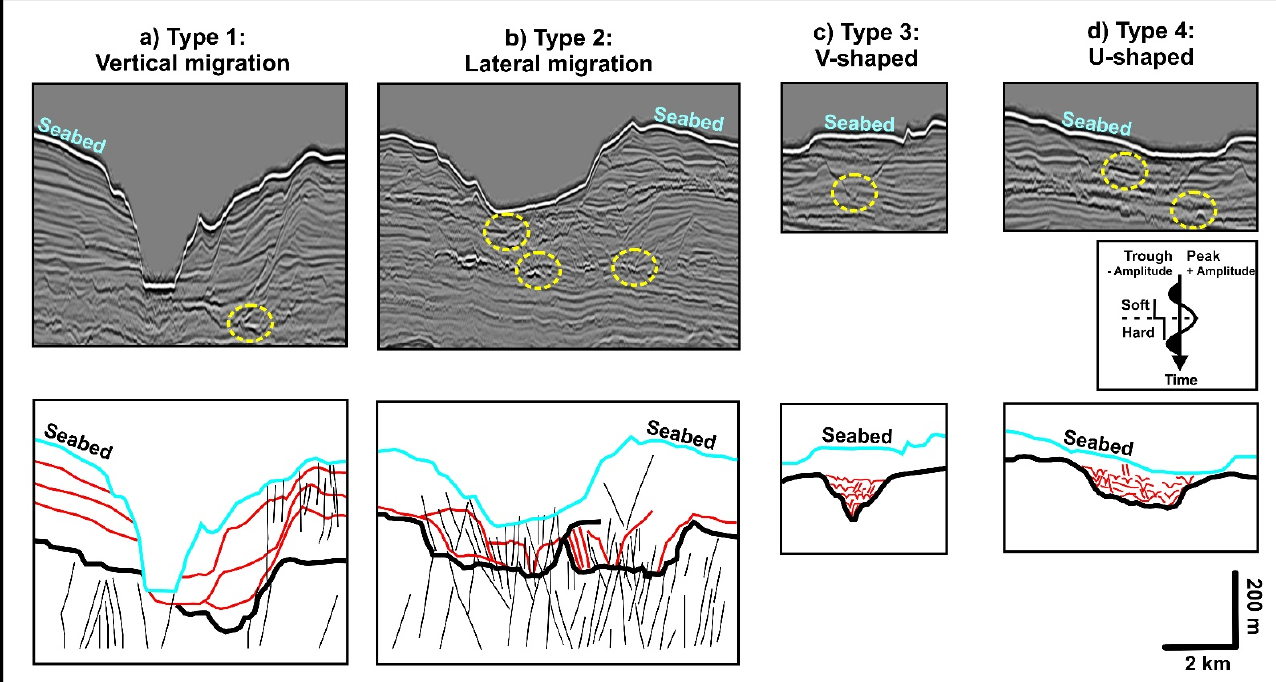
Figure 6. Seismic facies of filling deposits from four different channels complexes in this study. See Section 4.1 for detailed description. Note that the thick black line is the interpreted channel incision, the red line is the younger channel surface, the thin black line is the fault, and the yellow dashed line is isolated low to high seismic amplitude.